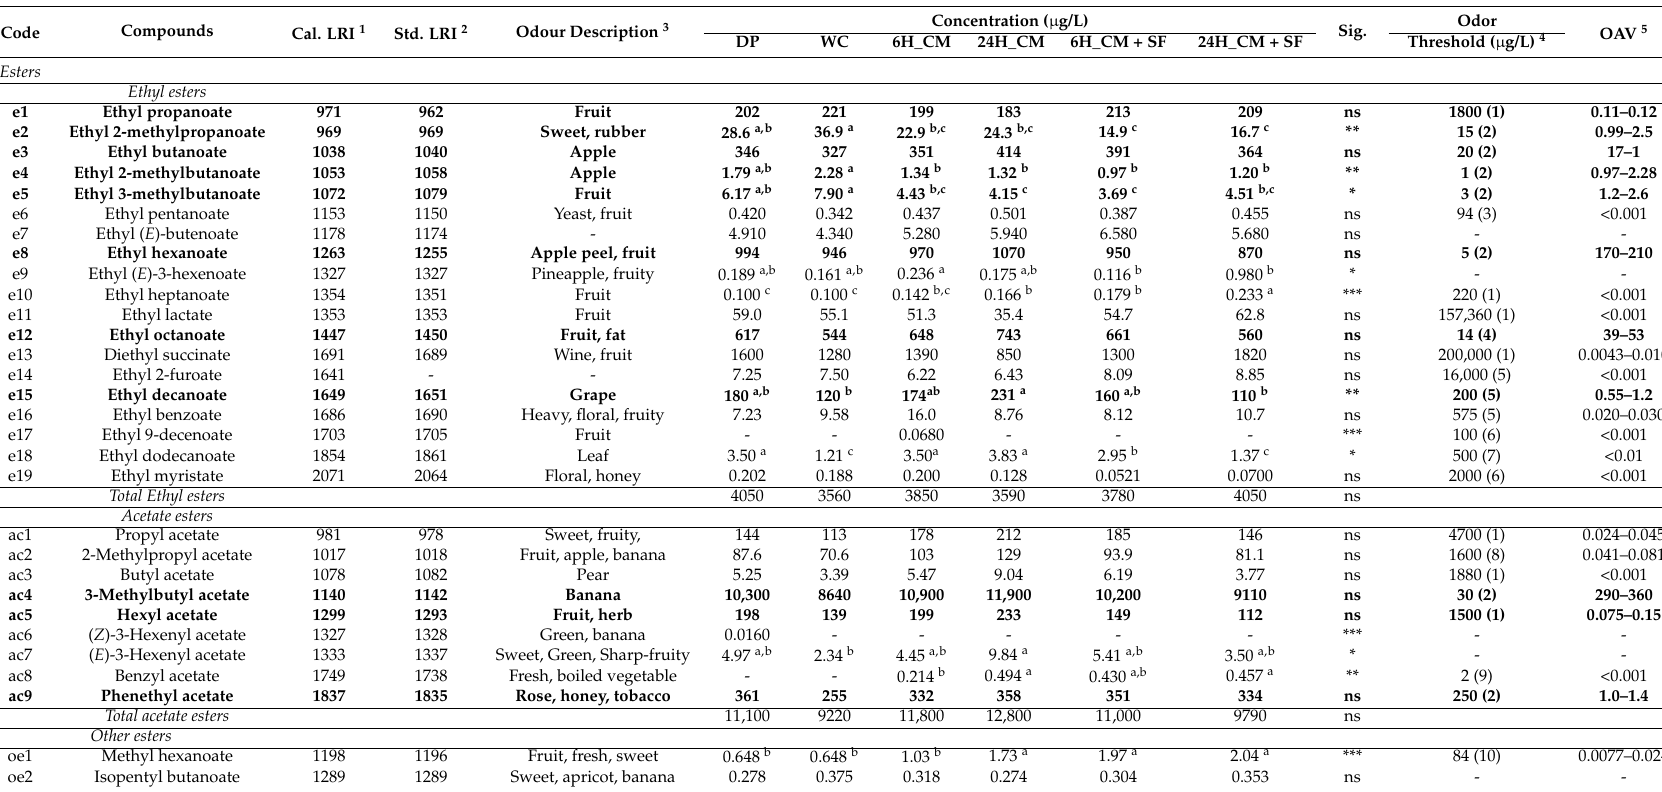
Table 4. Volatile compounds quantified in the wines under different pre-treatments. Values are presented as averaged concentrations over two replicates ( µ g/L). For compounds exhibiting significant differences between treatments, values labelled with different